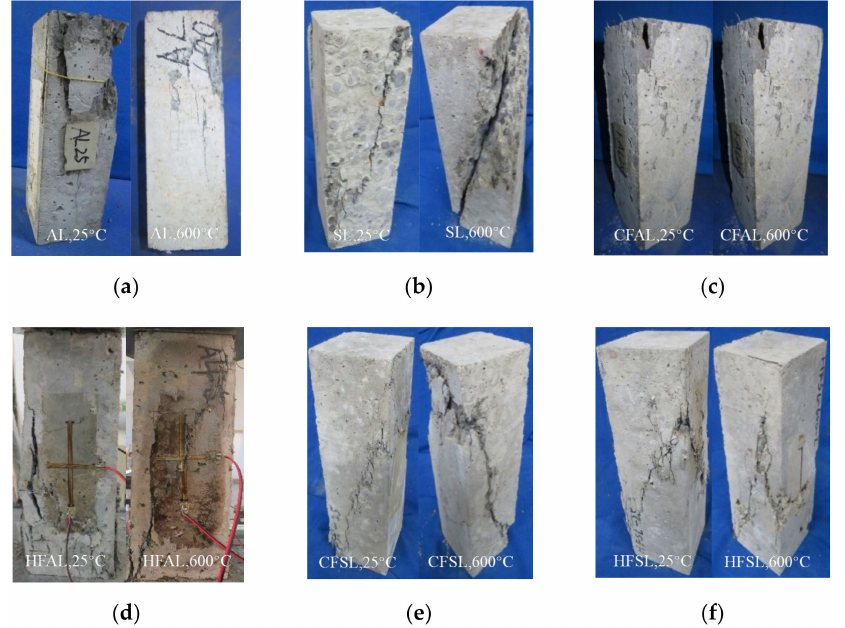
Figure 8. Failure mode of mixes after compression: ( a ) All-lightweight concrete (ALWC); ( b ) Semi- lightweight concrete (SLWC); ( c ) All-lightweight concrete with crimped shape steel fiber (CFAL); ( d ) All-lightweight concrete with Hooked end steel fiber (HFAL); ( e ) Semi-lightweight concrete with crimped shape steel fiber (CFSL); ( f ) Semi-lightweight concrete with hooked end steel fiber